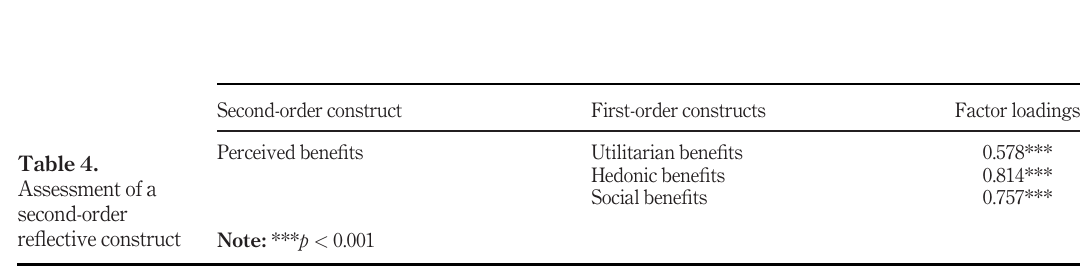
Table 4. Assessment of a